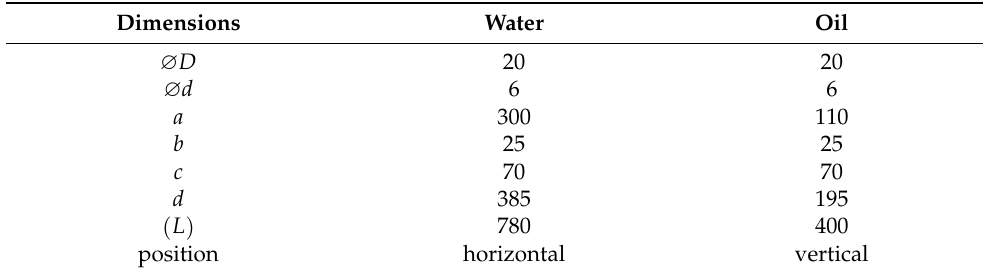
Table 1. Basic dimensions (mm), see Figure